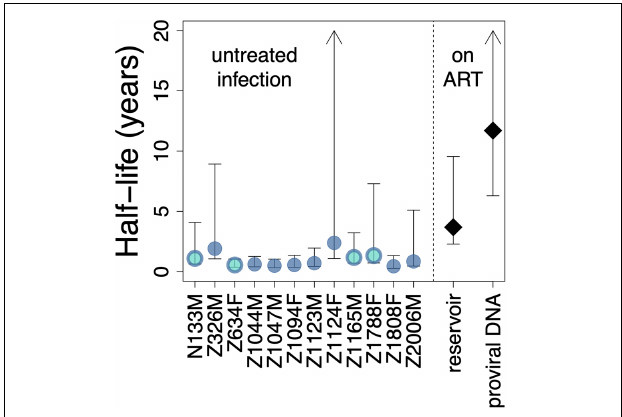
FIGURE 5 | Comparison of estimated pre-ART proviral decay rates with published rates of reservoir and proviral decay on ART. Estimated pre-ART proviral half-lives and associated 95% CI are shown for the 12 participants, alongside published rates of reservoir (Siliciano et al., 2003) and proviral (Golob et al., 2018) decay on ART. Bi-colored circles represent the four participants for whom proviral sampling was performed twice on ART. Arrowheads indicate upper 95% CIs of